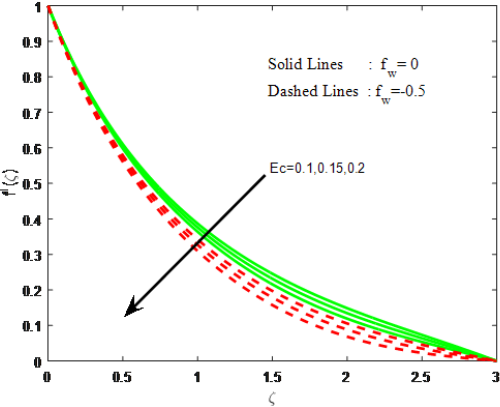
Fig. 6: The effect of Biot number Bi on velocity field